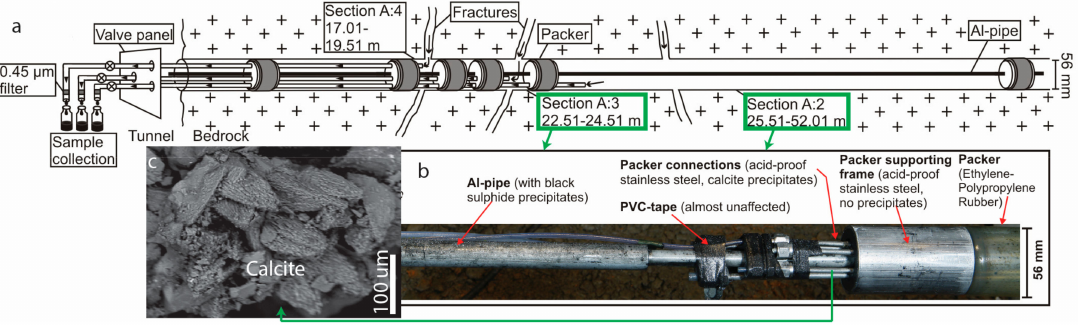
Figure 2. Borehole KA3105A at Äspö, with packers isolating water-conducting bedrock fractures ( a ) of which borehole sections A:2 and A:3 have been analyzed for 87 Sr / 86 Sr values in the waters and calcite. ( b ) Instrumentation with modern mineral precipitates, including calcite (back-scattered SEM-image, ( c ). b is modified from Drake et al. 2015 [51], reprinted with permission (#4900630138846) from